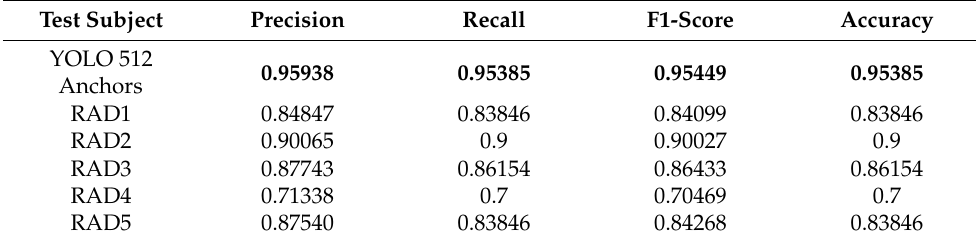
Table 5. RAD vs. AI—fracture-based evaluation on test set #2.